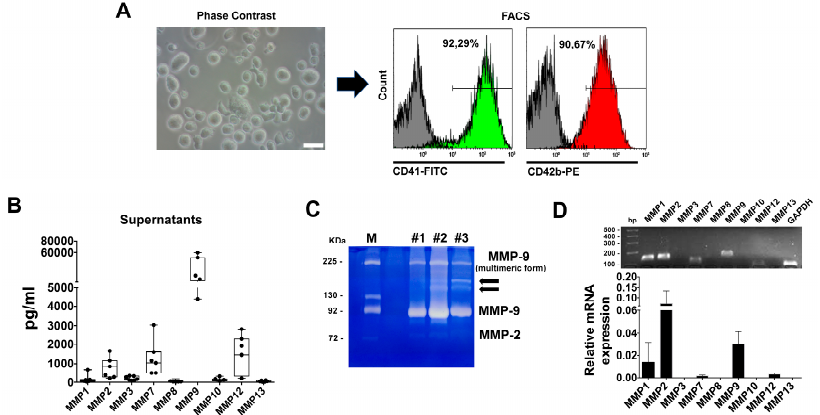
Figure 1. Expression profiling of MMPs in primary human Megakaryocytes. ( A ) Phase contrast image of Megakaryocyte (Mk) culture at day 13 of differentiation. Scale bar = 50 m. Purity was analyzed by FACS, after staining with Mk markers CD41 (Green histogram) and CD42b (Red histogram). FITC Isotype IgG and PE Isotype IgG were used to set the analytical gate (Grey histograms). ( B ) Profiling and quantification of MMPs in supernatants from 1 × 10 6 megakaryocytes at day 13 of differentiation. N = 7. ( C ) Representative zymography of Mk supernatants at day 13 of culture. Three independent samples are shown. M = Molecular Marker. Arrows indicate potential dimers of MMP-9 activated forms (160–180 kDa). ( D ) Representative RT-PCR products of MMPs in Mks at day 13 of differentiation and relative quantification from at least three independent experiments. GAPDH expression was used for normalization.